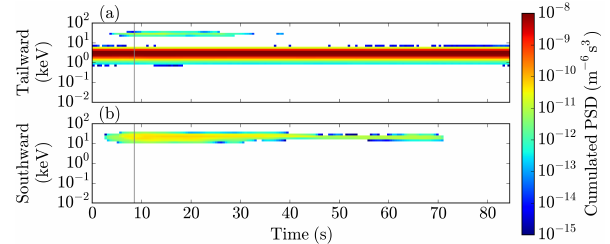
Figure 6. Energy–time spectrogram of the simulated local fore- shock crossing event at the location marked in Fig. 5. The grey vertical bar indicates the time of Fig. 5. The velocity distribution has been split into four sectors (sunward, southward, tailward and northward in the simulation/polar plane, ± 45 ◦ from the + x , − z , − x and + z direction respectively), two of which are plotted here. (a) The dense tailward population at an energy of a few kiloelec- tronvolt is the solar wind core. (b) The local foreshock beam forms the population at a few tens of kiloelectronvolt in the southward sec- tor and lasts almost 70s. Thus the expected observational signature is that of a field-aligned beam with a duration of the order of 1min.